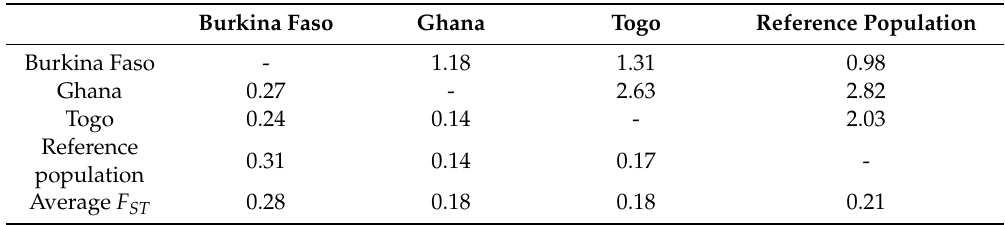
Table 3. Measure of genetic population di ff erentiation ( F ST ) (lower diagonal), and estimation of gene flow (Nm) (upper diagonal) within and among the four gene pools of maize